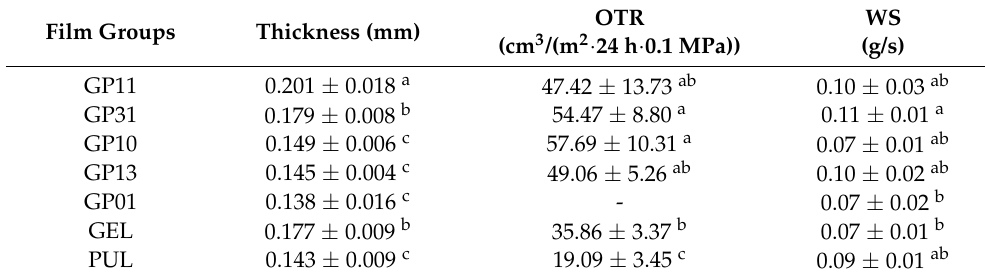
Table 2. Thickness, OTR and WS of various